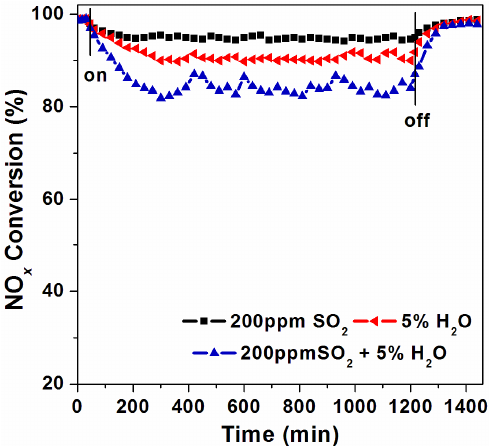
Figure 7. Influence of H 2 O and/or SO 2 on NO x conversion over Fe0.5 ‐ W ‐ Ce catalyst. Reaction conditions: [NO x ] = 450 ppm, [NH 3 ] = 450 ppm, 2.5% O 2 , N 2 as balance, GHSV = 20,000 h − 1 .